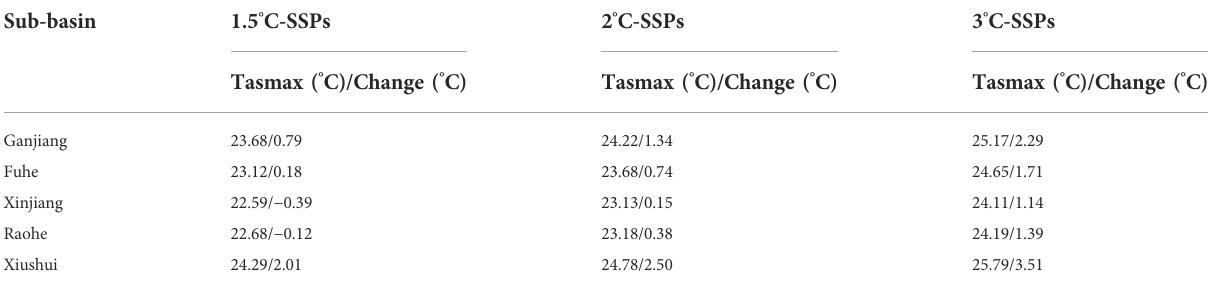
TABLE 7 Same as Table 5 but for the Tasmax in the